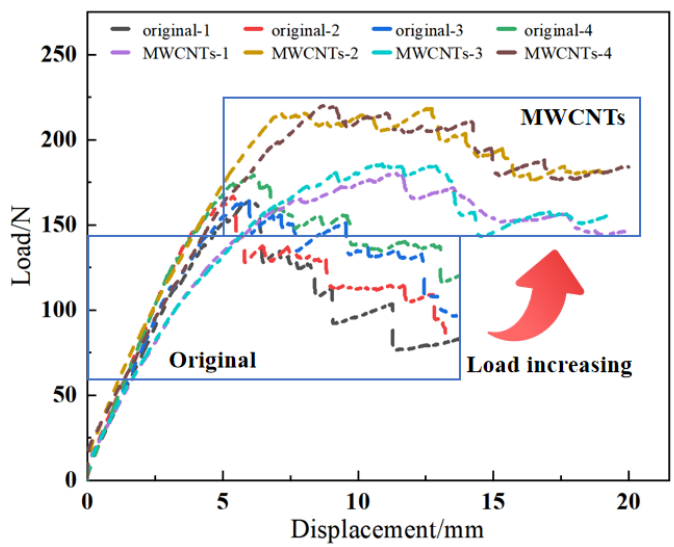
Figure 4. Load-displacement curves from the DCB test.